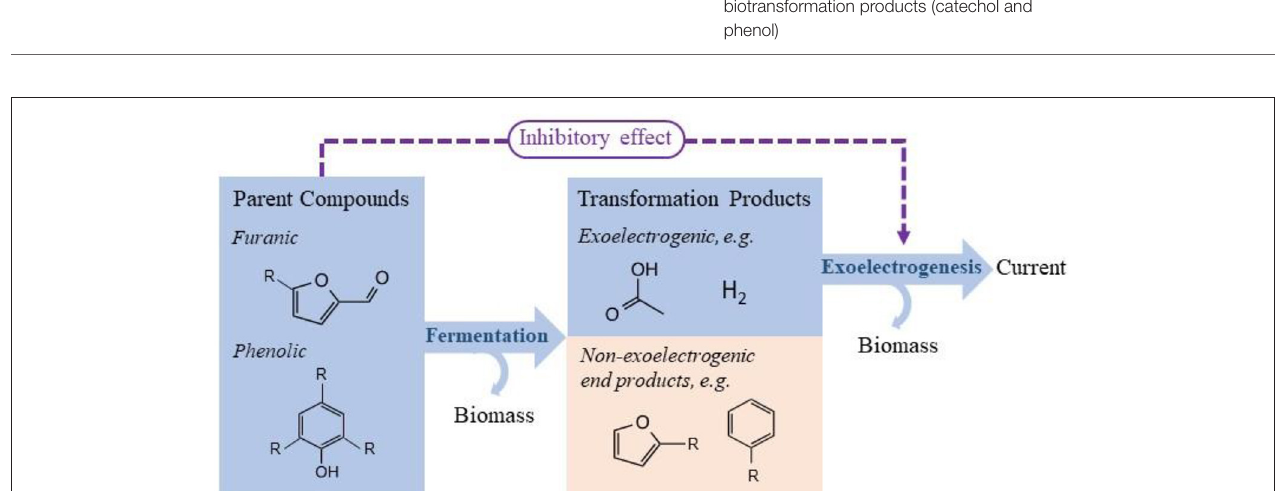
FIGURE 6 | Overview of bioanode processes extracting electrons from furanic and phenolic compounds.